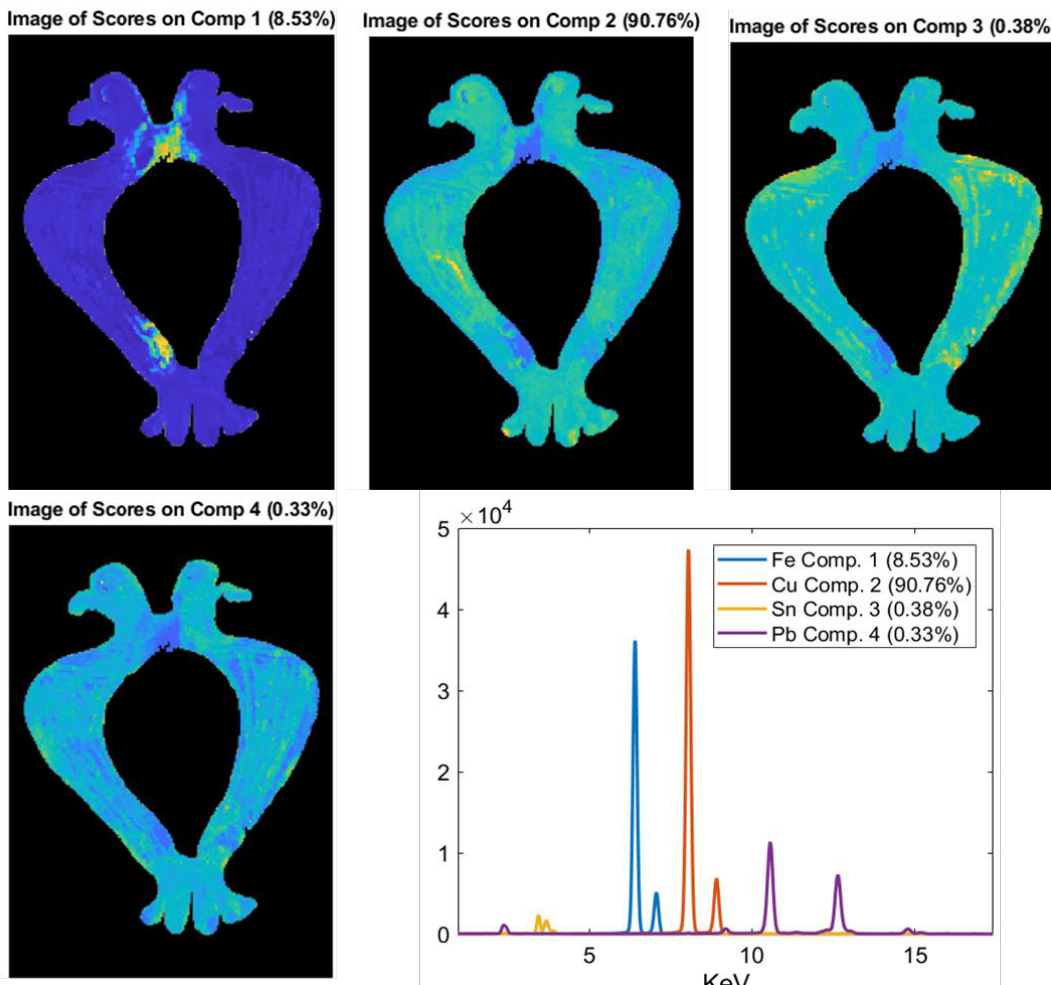
Figure 14. MCR analysis on the XRF spectra of the zoomorphic fibula 4021_12. This analysis highlights the di ff erence in composition between the copper-based alloy (Comp. 2) and the parts rich of iron (Comp.